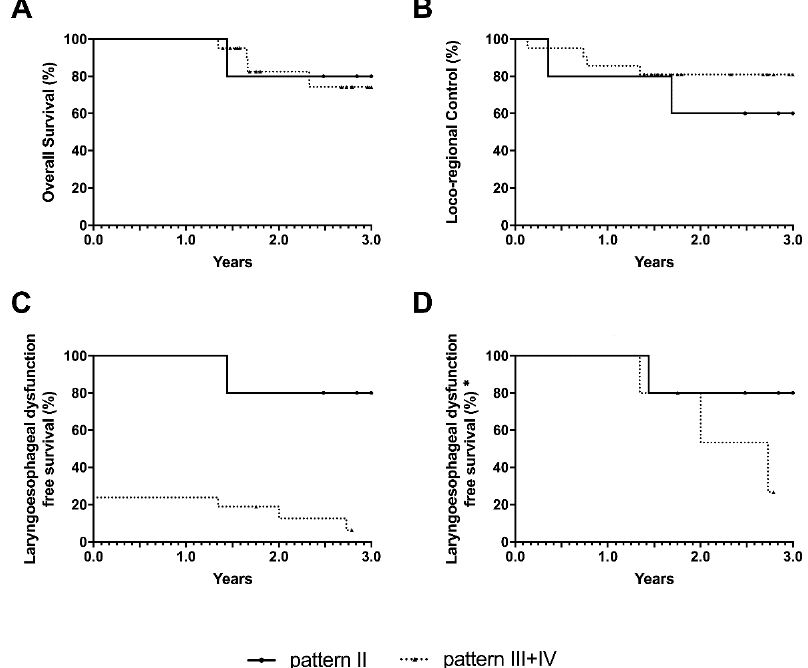
Figure 7. Oncologic outcomes at 3 years for pattern 2 compared with those belonging to pattern 3–4: